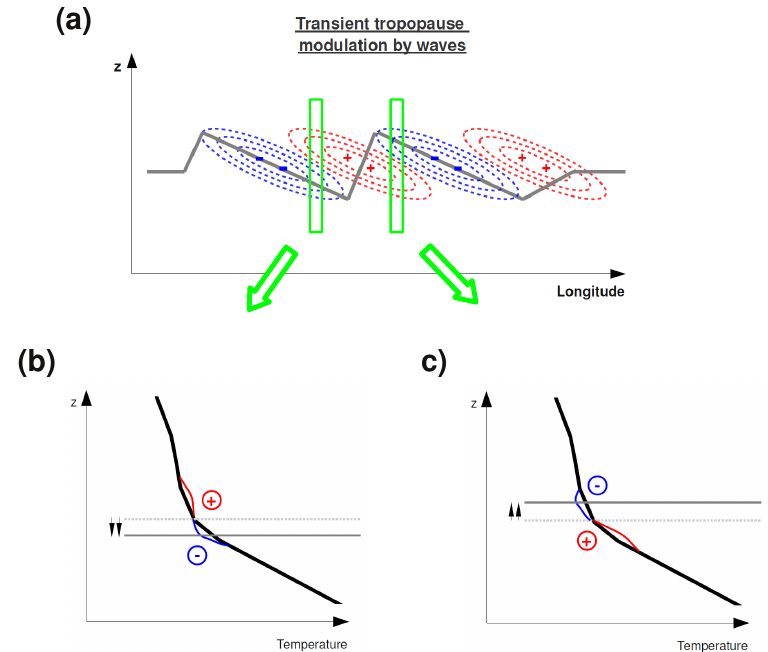
Figure 2. (a) Schematic of transient tropopause modulation by an idealized wave with westward vertical tilt, as a snapshot of the wave’s temperature anomalies (dashed contours: positive red, negative blue) and the undulating tropopause (thick, solid grey line). Green boxes represent the local samples for the bottom row. (b) Ground-based mean temperature profile (thick black line, similar to the midlatitude profile from Birner, 2006, Fig. 8), zonal-mean tropopause height (grey dashed line), the local wave temperature anomalies superimposed on the zonal-mean temperature profile (positive red, negative blue), and the resulting locally lower tropopause (solid grey line, double arrow). Panel (c) is the same as (b) but with the opposite sign of the anomalies and a locally higher